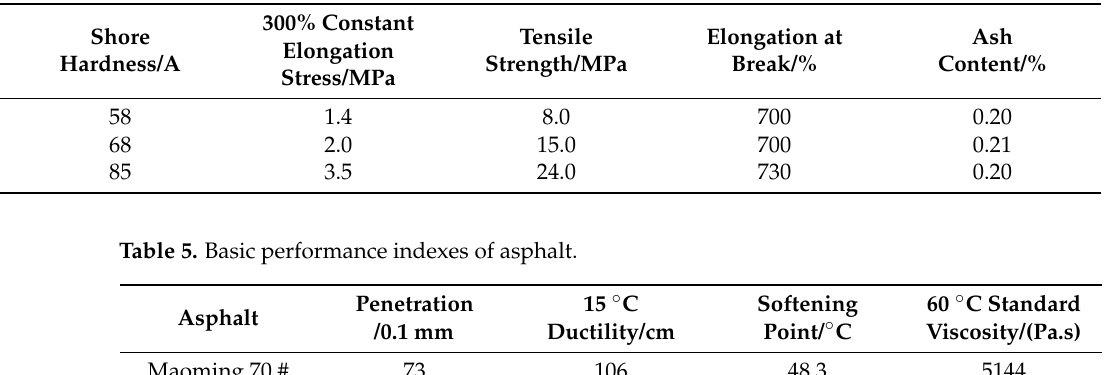
Table 4. Basic performance indexes of SBS with different block ratios.